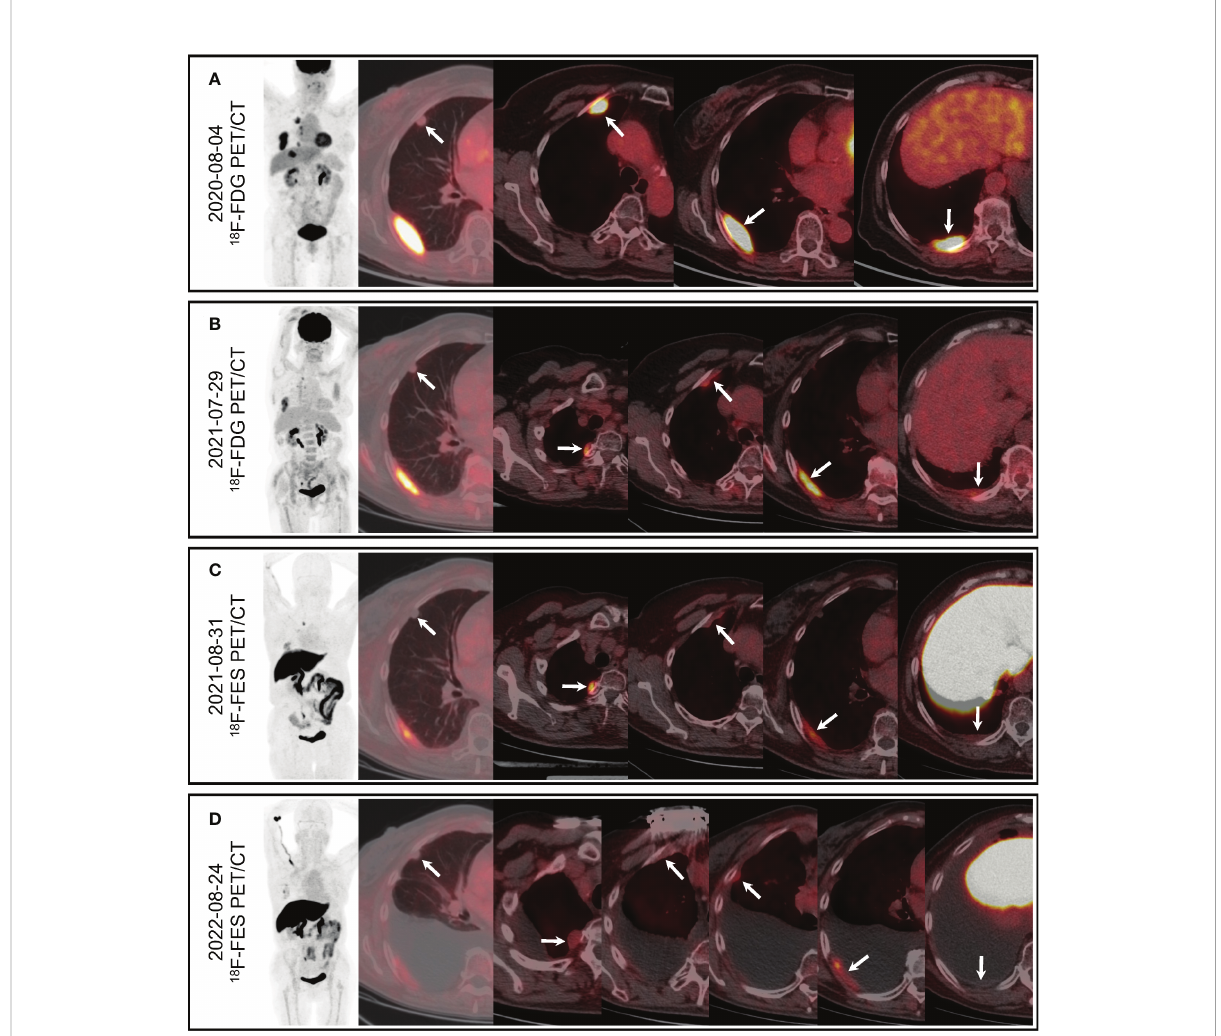
FIGURE 2 PET/CT. (A) 18 F-FDG PET/CT showed mild FDG uptake of the largest pulmonary nodule (arrow, SUVmax 1.6) and increased FDG uptake of the multiple pleural masses (arrows, SUVmax 9.4). (B) Followed-up 18 F-FDG PET/CT showed mild FDG uptake of the largest pulmonary nodule (arrow, SUVmax 1.2) and increased FDG uptake of the multiple pleural masses (arrows, SUVmax7.0). (C) Pulmonary nodule was negative on 18 F- FES PET/CT (arrow), and multiple pleural masses showed obvious FES uptake (arrows, SUVmax 5.0). (D) Pulmonary nodule was negative on followed-up 18 F-FESPET/CT (arrow), and multiple pleural masses showed different levels of FES uptake (arrows,